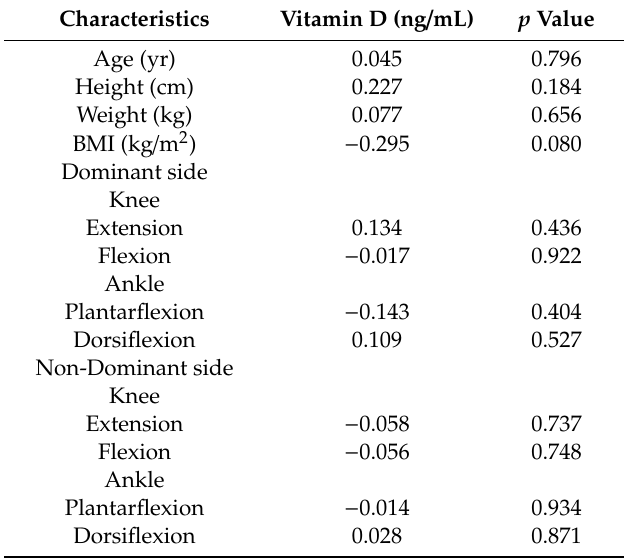
Table 2. Correlation coe ffi cients (r) between vitamin D level and other